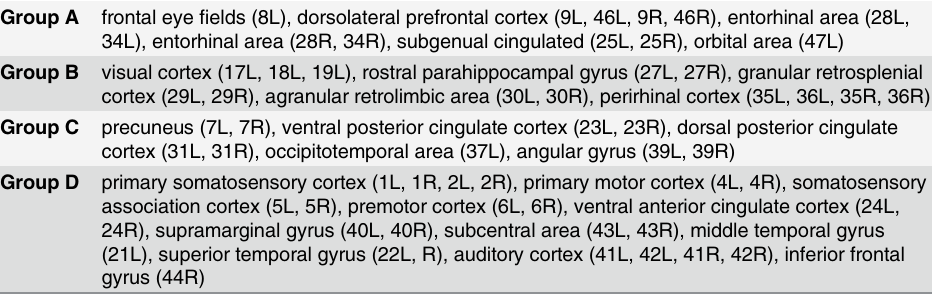
Table 2. Results from dendrogram analysis for the NE task; four groups of sources were found to be common to the NE-IL and the NE-IT conditions in the upper alpha